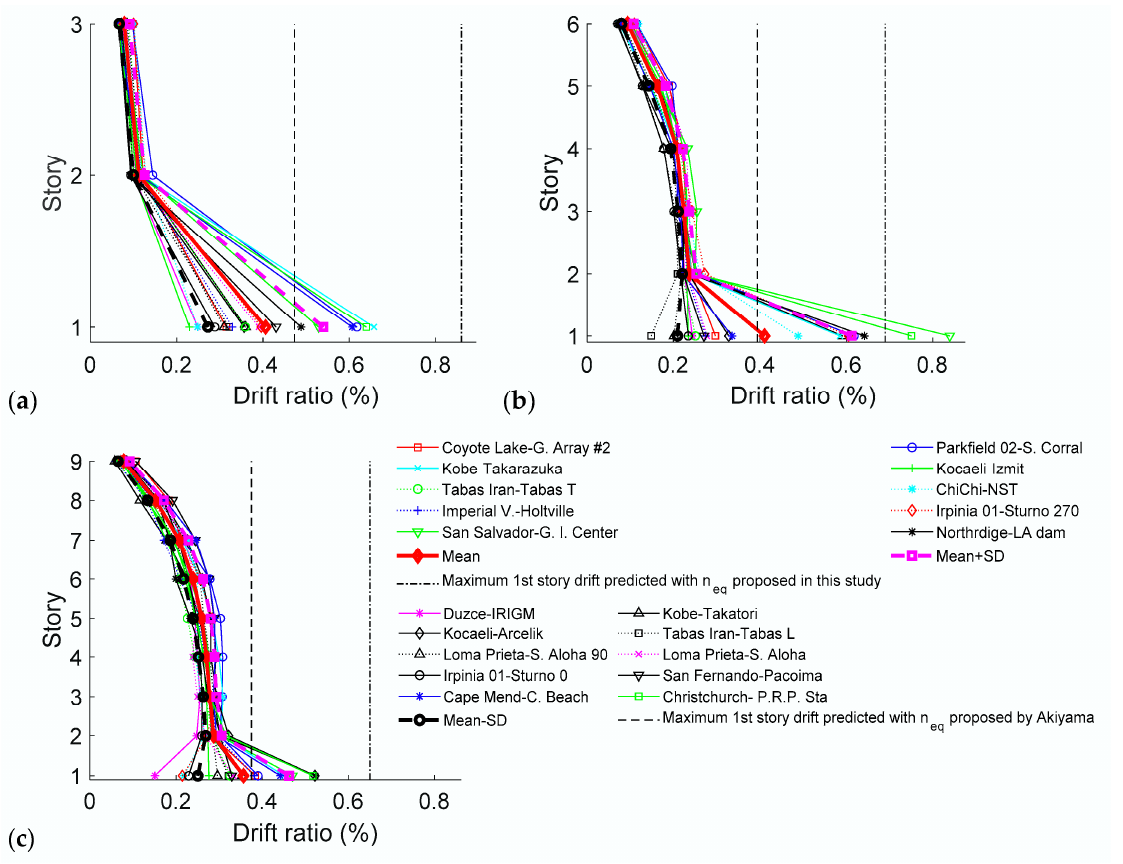
Figure 6. Maximum inter-story drift ratios of prototypes N3 ( a ), N6 ( b ) and N9 ( c ).